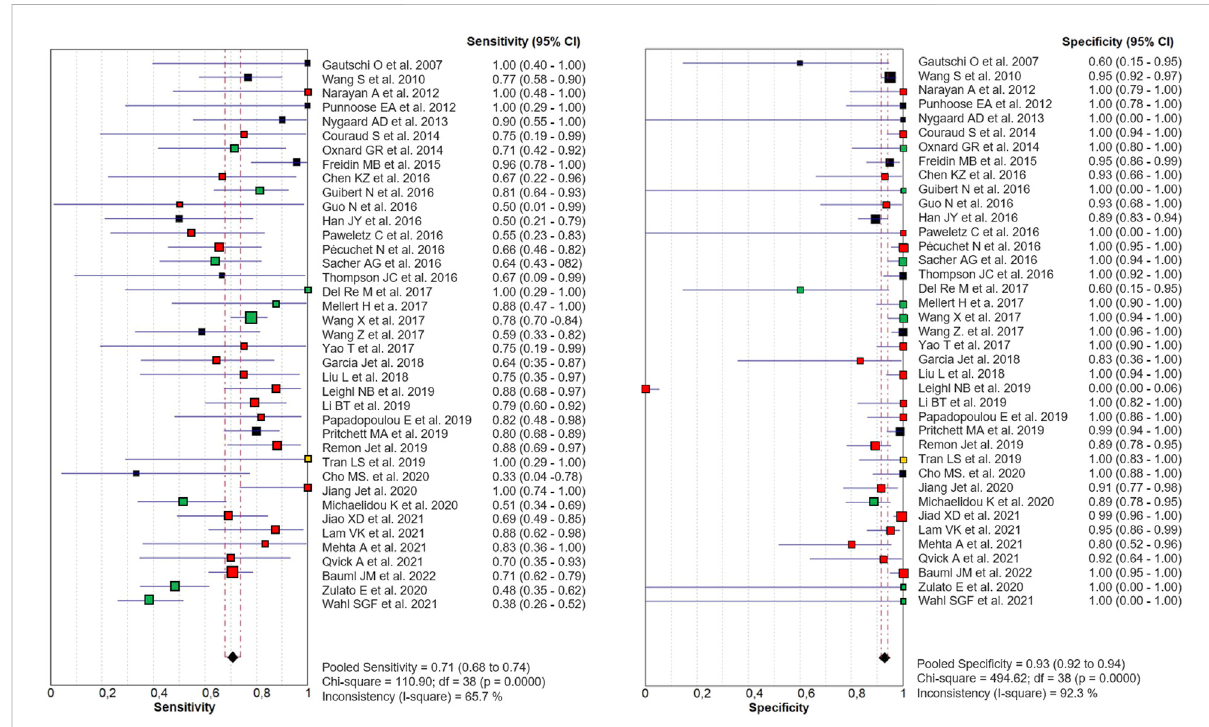
FIGURE 2 Paired Forest Plot of sensitivity and speci fi city of cfDNA testing in detecting KRAS mutation in NSCLC for 39 studies in the meta-analysis. Random-effects (RE) model used. The square and horizontal bars represented study-speci fi c sensitivity and speci fi city and 95% con fi dence interval (CI). Squares in different colors represent a different diagnostic method (red = Targeted NSG; blue = ddPCR; yellow = both; black = other method). Diamonds represented the overall results. The pooled sensitivity was 0.71 (95% CI 0.68 – 0.74) and the speci fi city was 0.93 (95% CI 0.92 –